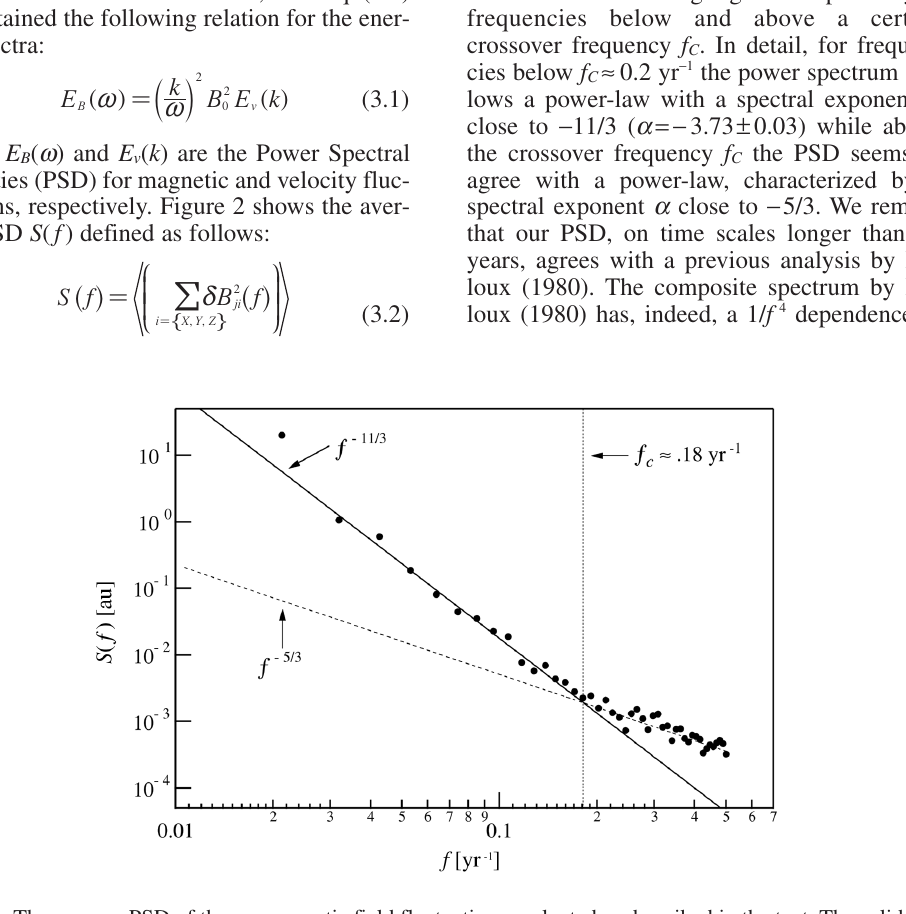
Fig. 2. The average PSD of the geomagnetic field fluctuations evaluated as described in the text. The solid and dashed lines refer to non-linear best fit using a power law. Spectral slopes are approximately –11/3 and –5/3 for frequencies lower or higher than the crossover frequency ƒ c ≈ 0.2 yr − 1 . The vertical dotted line denotes to the crossover